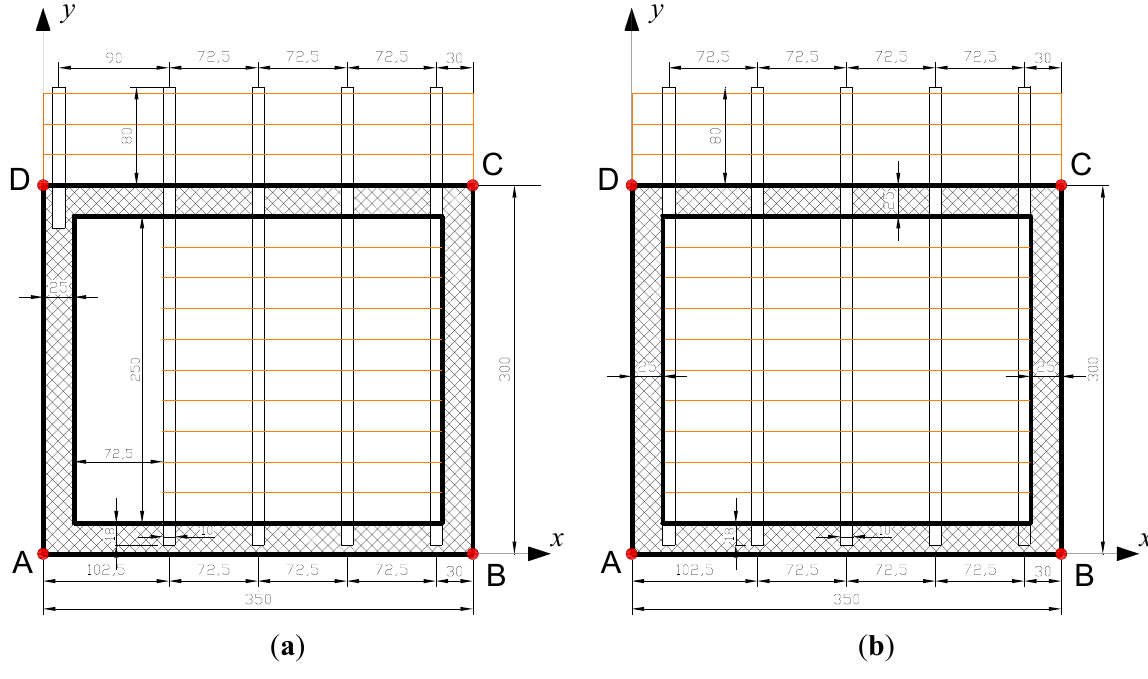
Figure 2. Plan dimensions (cm) of the prototype: ( a ) first floor and ( b ) second